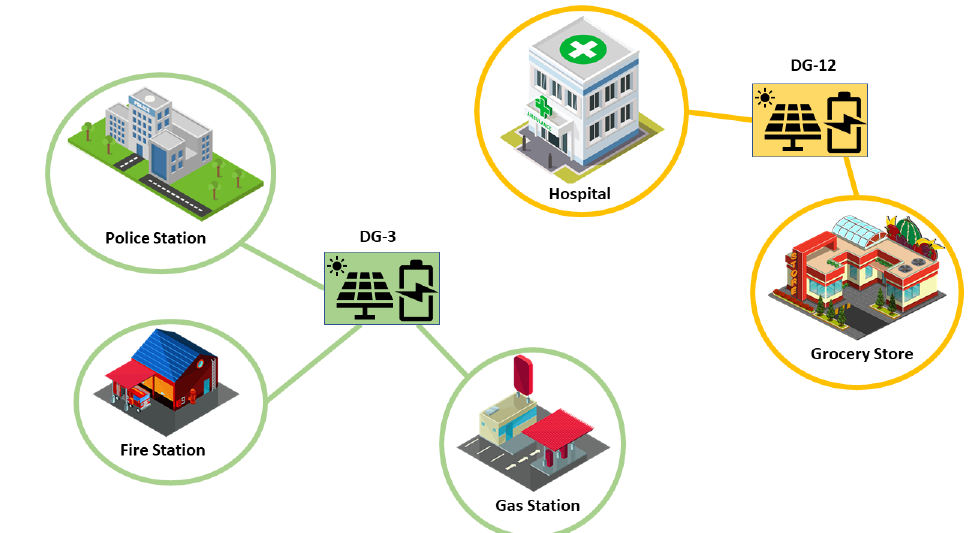
Figure 1. Example assignment using 2 DGs to supply 5 DNs. DG unit 3 is assigned, with the DNs representing police, fire, and gas stations. DG unit 12 is assigned, with DNs representing the hospital and grocery